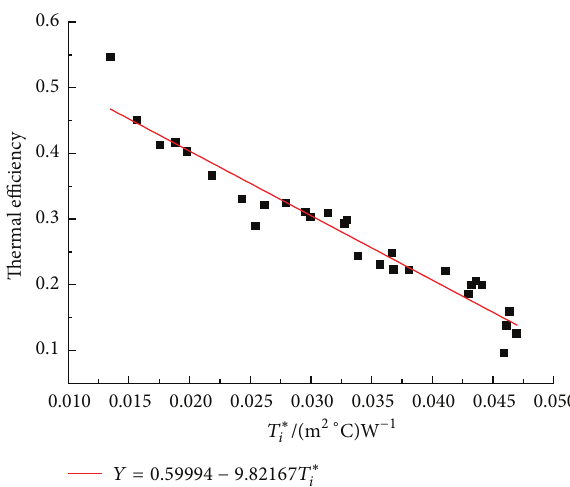
Figure 11: Optical efficiency on different PV temperatures. Figure 12: Thermal efficiency fit curve of the experimental results. optical efficiencies were all above 90.0% within the deflection angles of 0 ∘ –0.5 ∘ , and at the deflection angles of 0.6 ∘ and 0.7 ∘ , the optical efficiencies were still above 85.0%. At the same time, the flux distribution at different deflection angles was also demonstrated and